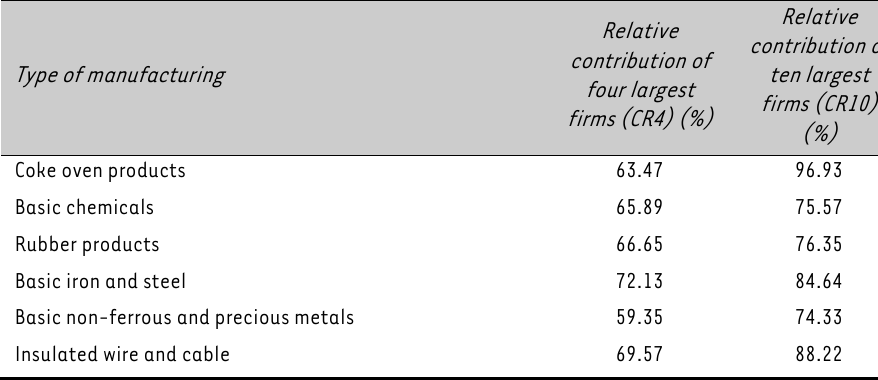
Some upstream concentration ratios in the manufacturing industry according to output: 2005